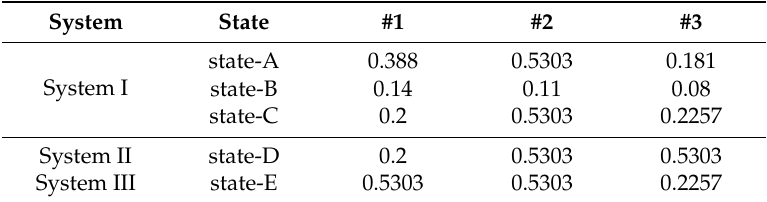
Table 3. Proportional coefficient k p of the current controller for different